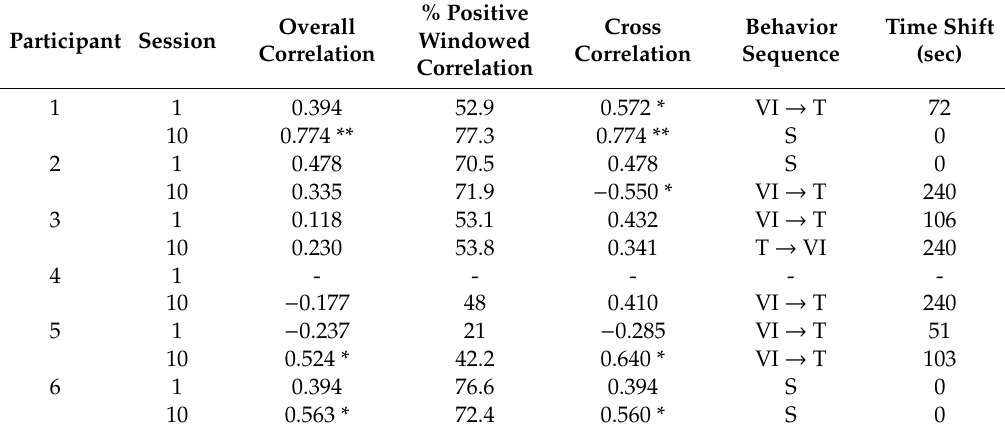
Table 4. Relations between verbal initiative and spontaneous touch.